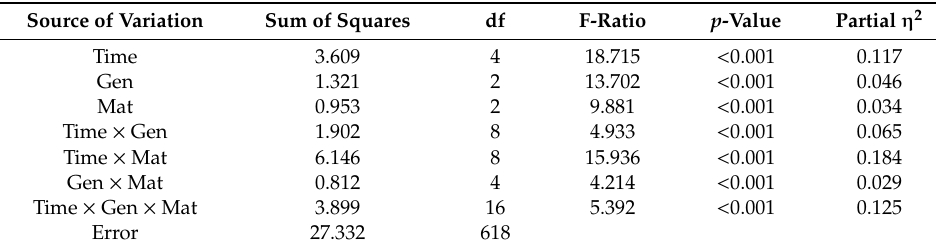
Table 1. ANOVA summary table for the ascorbic acid.